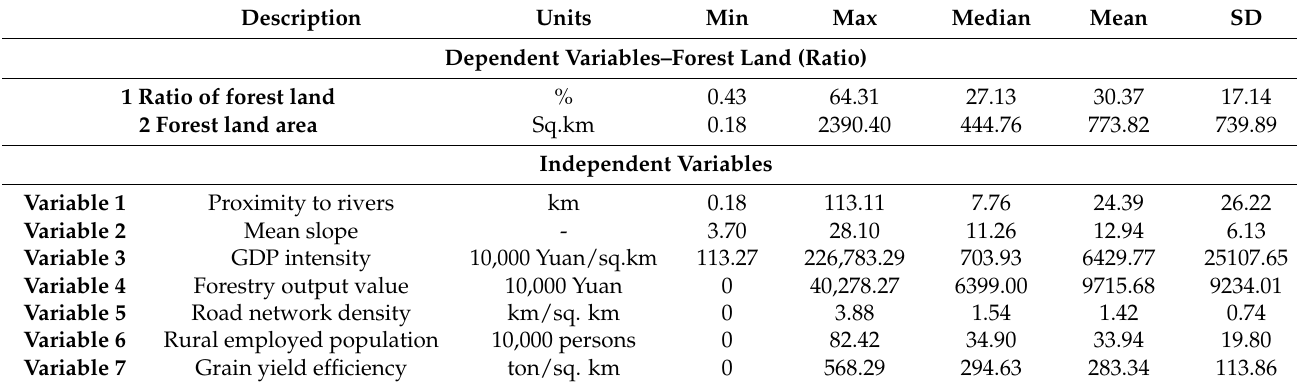
Table 1. Dependent and independent